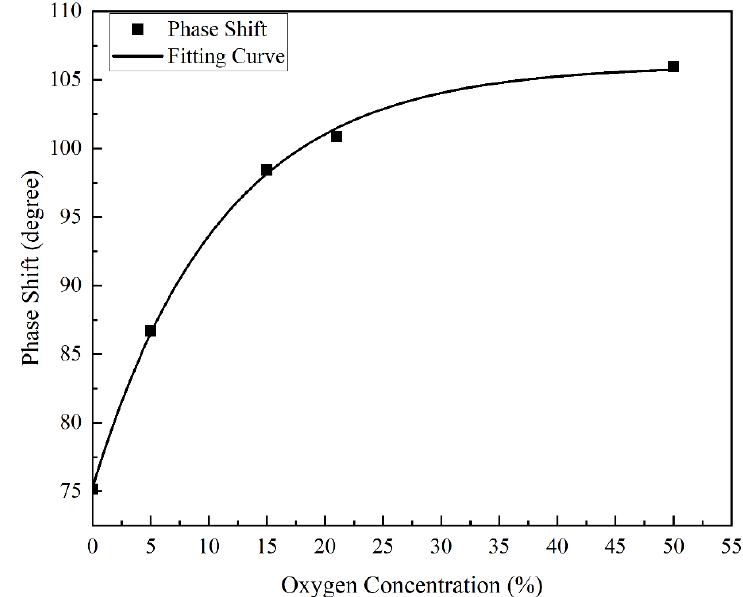
Figure 11. Lag phase shift of fluorescence relative to excitation for different concentrations of oxy- gen.